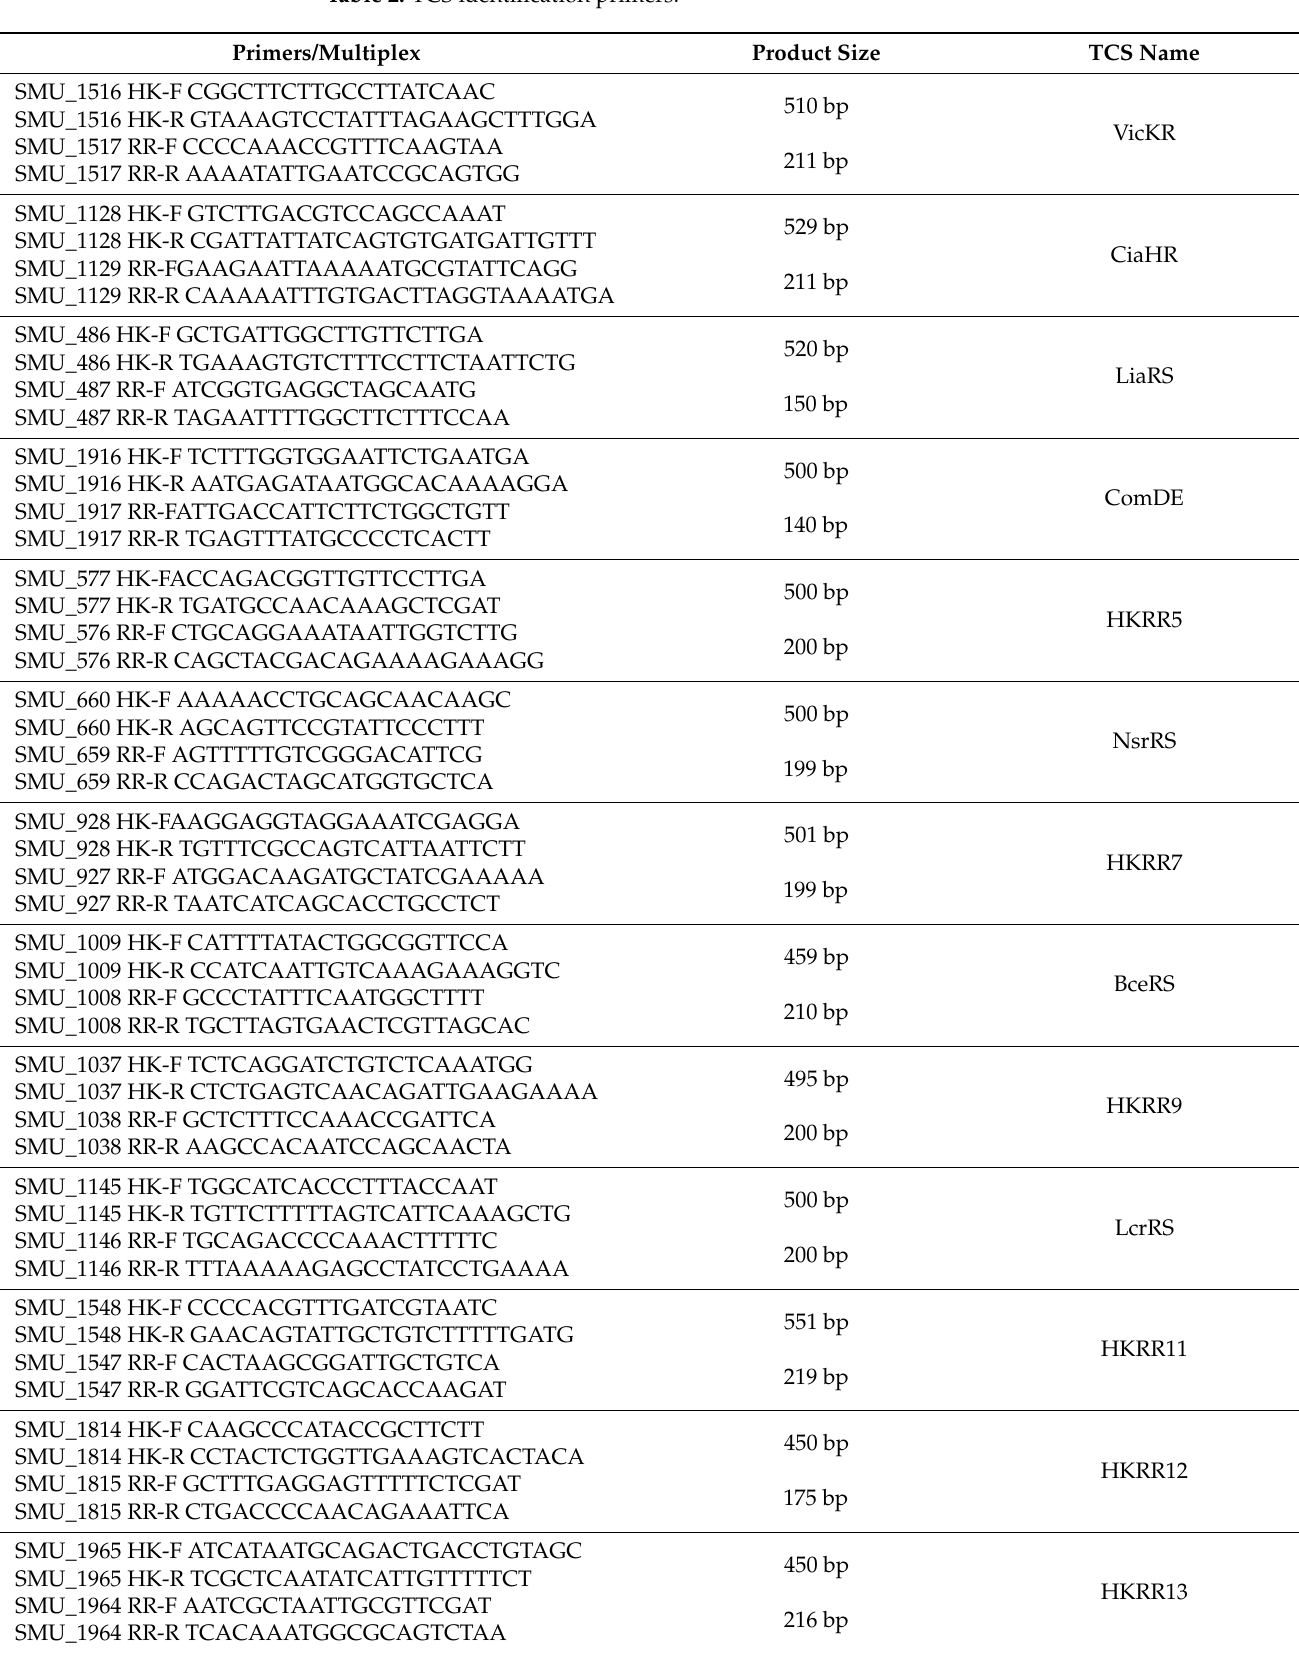
Table 2. TCS identification